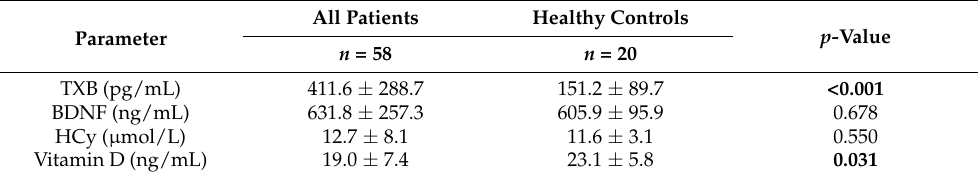
Table 2. Baseline levels of TXB, BDNF, HCy, and vitamin D in all patients and healthy controls. All Patients Parameter